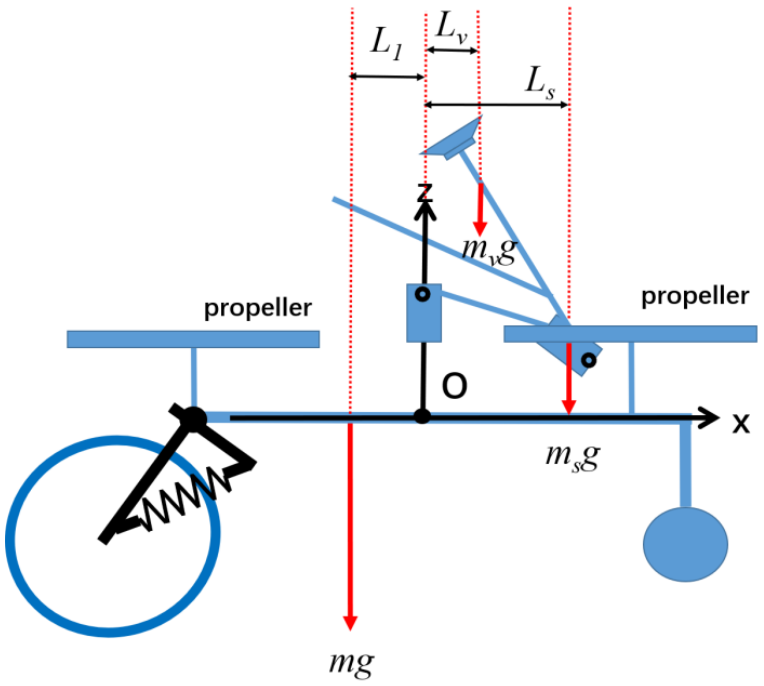
Figure 11. The robot balancing the center of gravity by adjusting the servo.